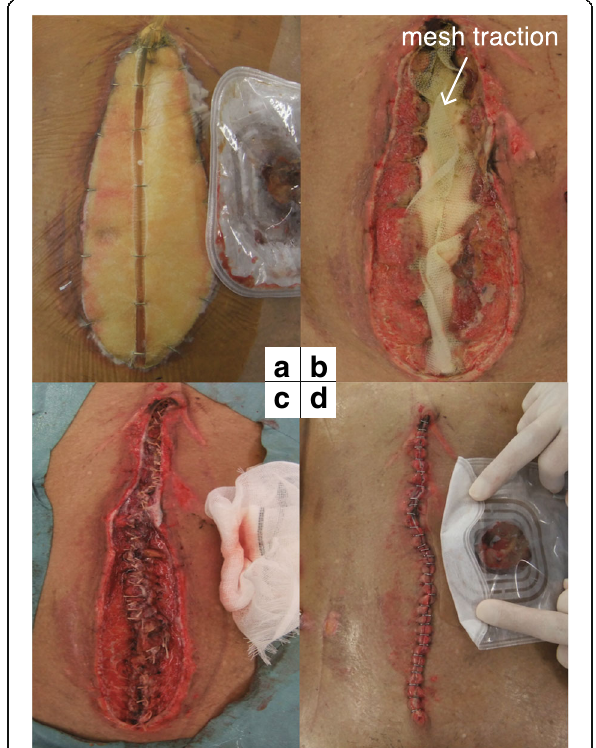
Fig. 7 Findings at the fifth operation. a Prior to the operation. b The medical form padding was removed and the tension of the